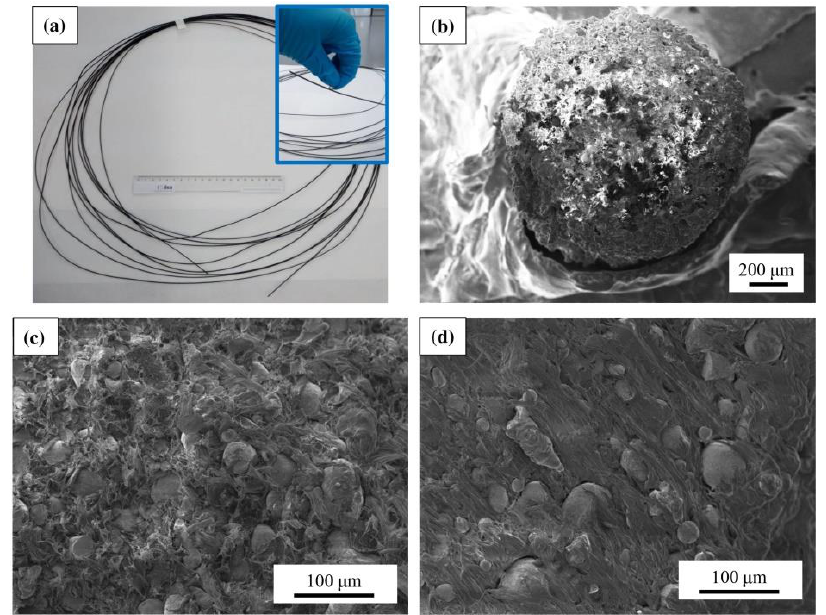
Figure 2. ( a ) Extruded MnAlC–PE magnetic filament (with a 20 cm ruler for scale comparison); SEM images of ( b ) the circular cross-section of the MnAlC-PE filament, and internal filament morphology for filling factors ( c ) 72.3% and ( d ) 52.1%. From [40], originally published under a CC-BY